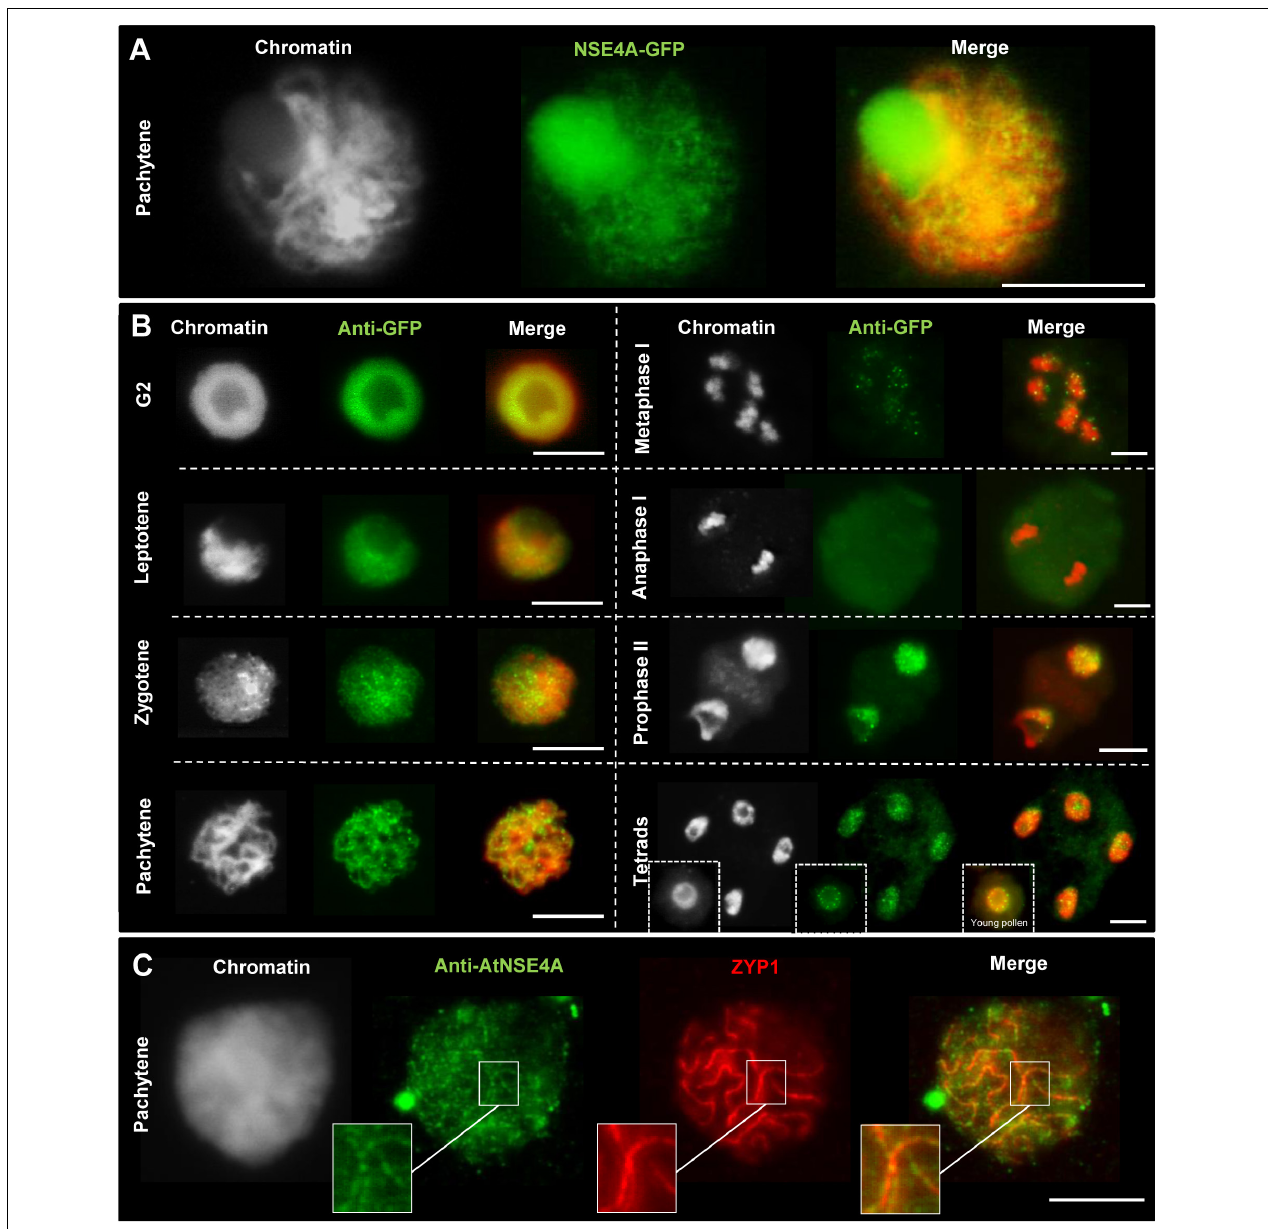
FIGURE 4 | Localization of NSE4A during the meiosis of A. thaliana (A,B) and the closely related species B. rapa (C) . (A) Line-like NSE4A-GFP signals are detectable in an unfixed meiocyte at pachytene of a transgenic pnse4A::gNse4A::GFP A. thaliana plant. (B) Dynamics and localization of NSE4A-GFP signals during meiosis of pnse4A::gNse4A::GFP transgenic A. thaliana plants, detected by anti-GFP. The NSE4A-GFP signals are detectable in G2, leptotene, zygotene, and pachytene cells. The signals are weak or not visible in condensed metaphase I and anaphase I chromosomes, respectively, but are recovered in prophase II, tetrads and young pollen. (C) Anti-AtNSE4A labels the synaptonemal complex of B. rapa and colocalizes to ZYP1 during pachytene. Gray color indicates chromatin counterstained with DAPI. Bars = 10 µ